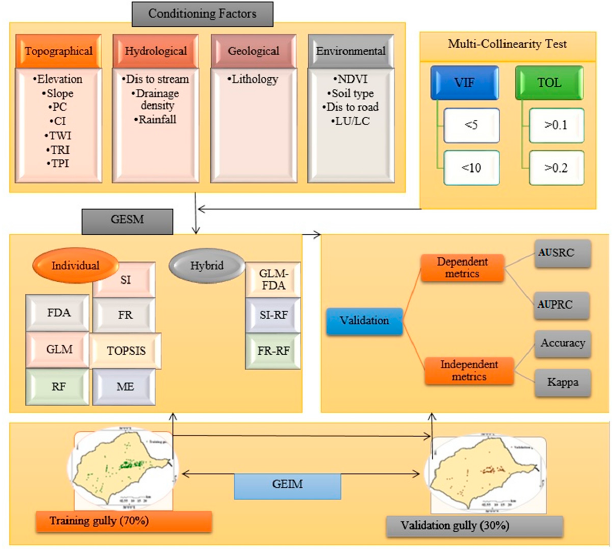
Figure 4. Flowchart of research in the study area.